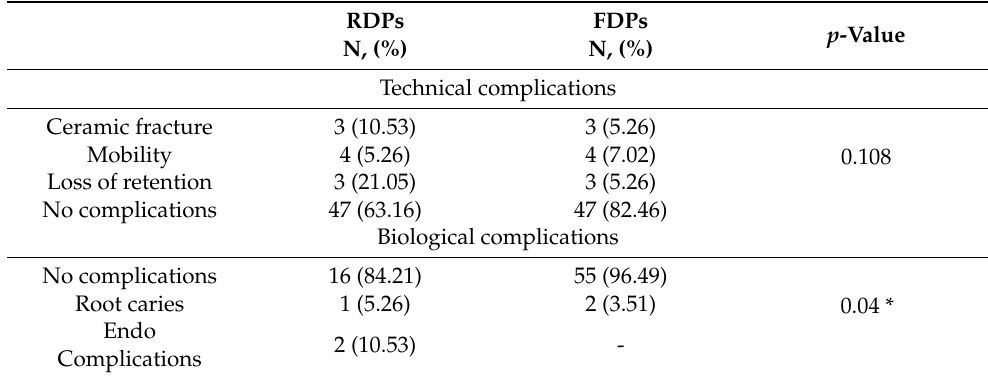
Table 4. Description of technical and biological complications by the type of prostheses.